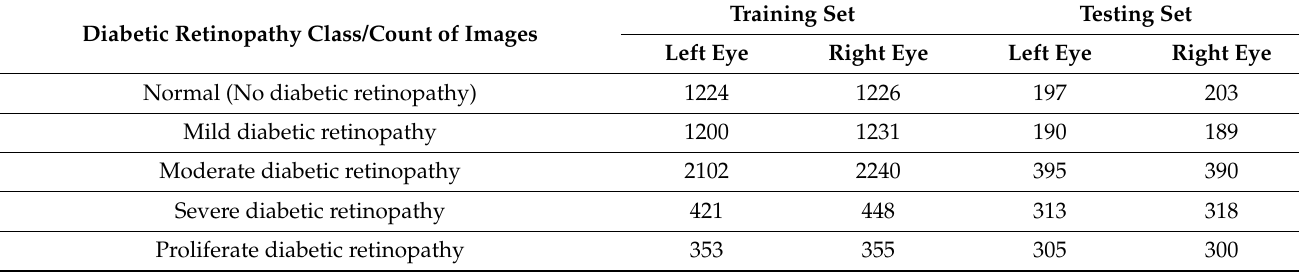
Table 4. The count of images in each diabetic retinopathy